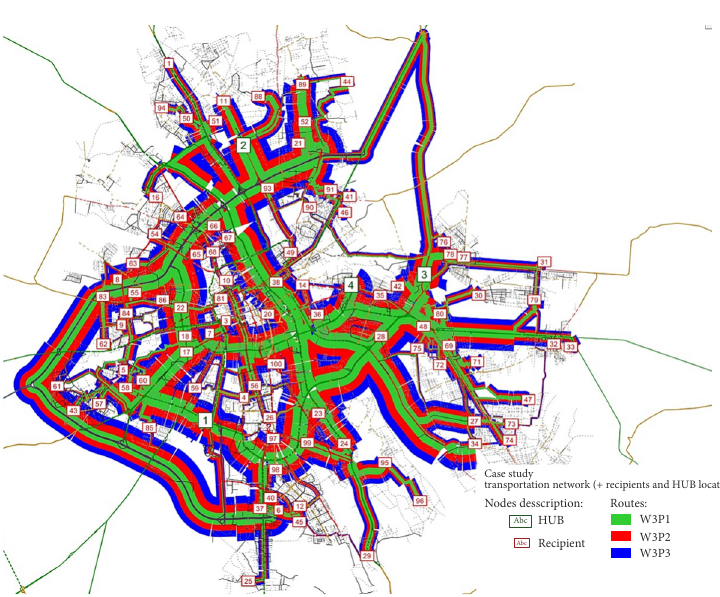
Fig. 4. Routes in variant